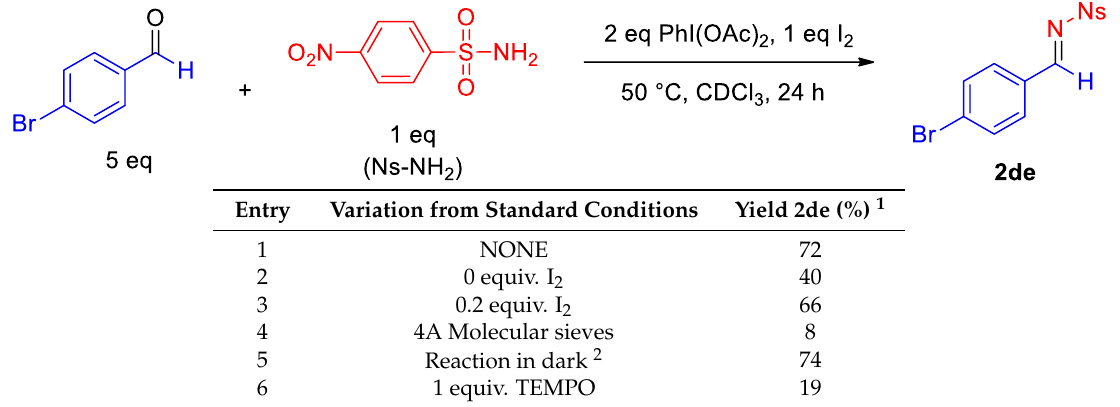
Table 2. Control reactions for the iminoiodinane/I 2 formation of N -sulfonyl imines.